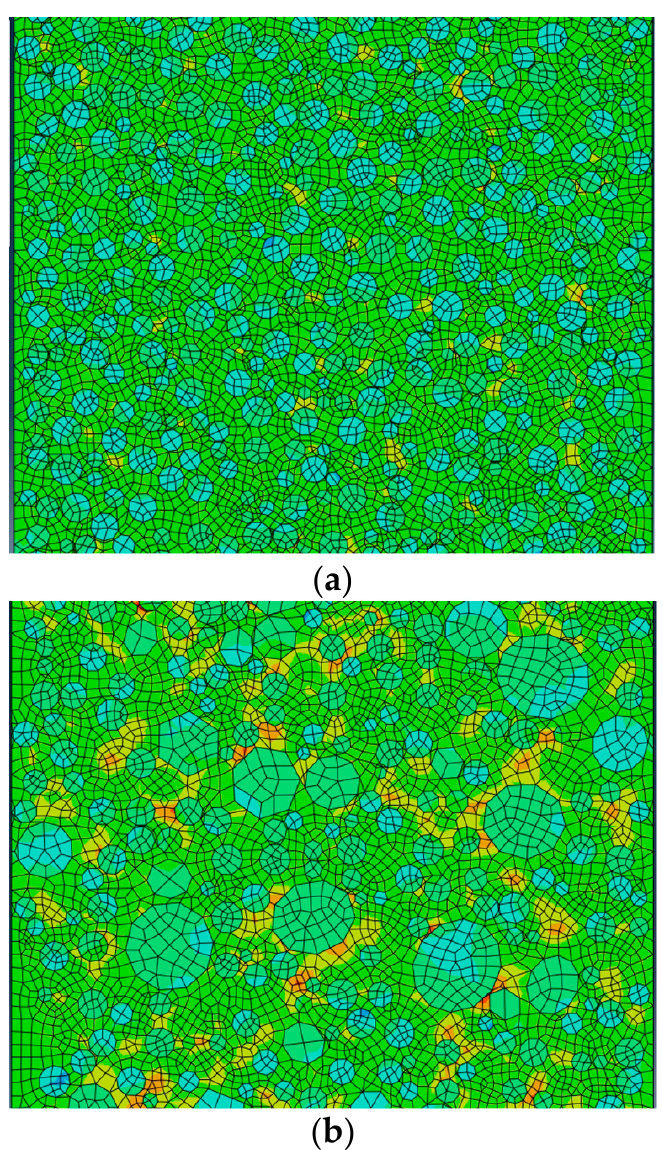
Figure 5. HSGM and concrete strain cloud diagrams. ( a ) HSGM strain cloud diagram, ( b ) concrete strain cloud diagram.